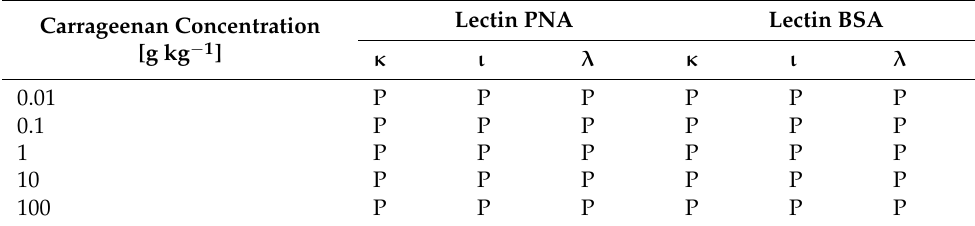
Table 3. Results of LoD determination of κ-, ι- and λ-carrageenan in model samples of meat products.